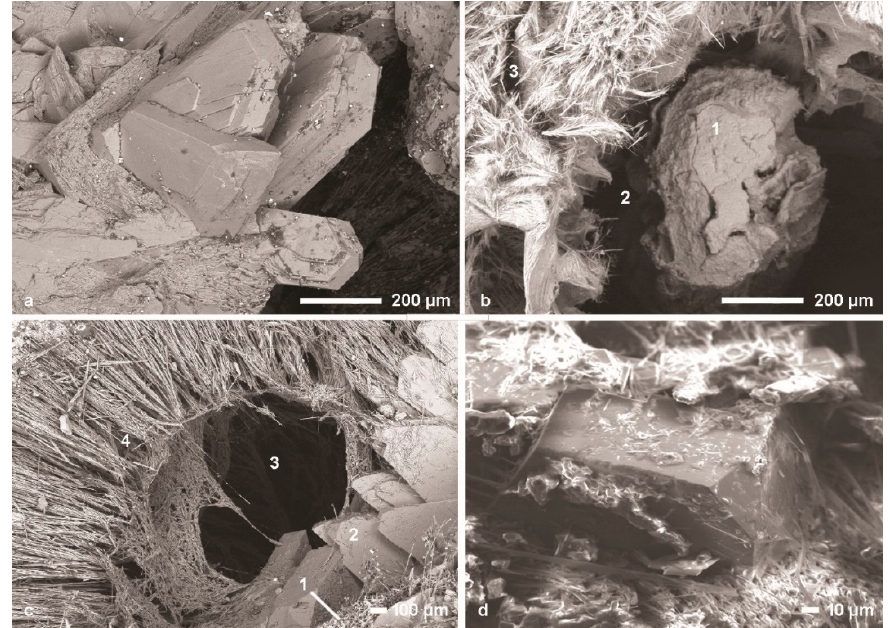
Figure 14. SEM micrographs showing the distribution of zeolites and feldspar: ( a ) Sample JAM ‐ 10: euhedral stilbite ‐ Ca crystals. ( b ) Sample JAL ‐ SM 01: 1 ‐ central SFF, 2 ‐ empty tube, and 3 ‐ mordenite. ( c ) Sample JAM ‐ 10: 1 ‐ filamentous fabric, 2 ‐ euhedral heulandite/clinoptilolite, 3 ‐ empty spherical space, and 4 ‐ fibrous mordenite. ( d ) Sample JAM ‐ 10: subhedral plagioclase with mordenite.